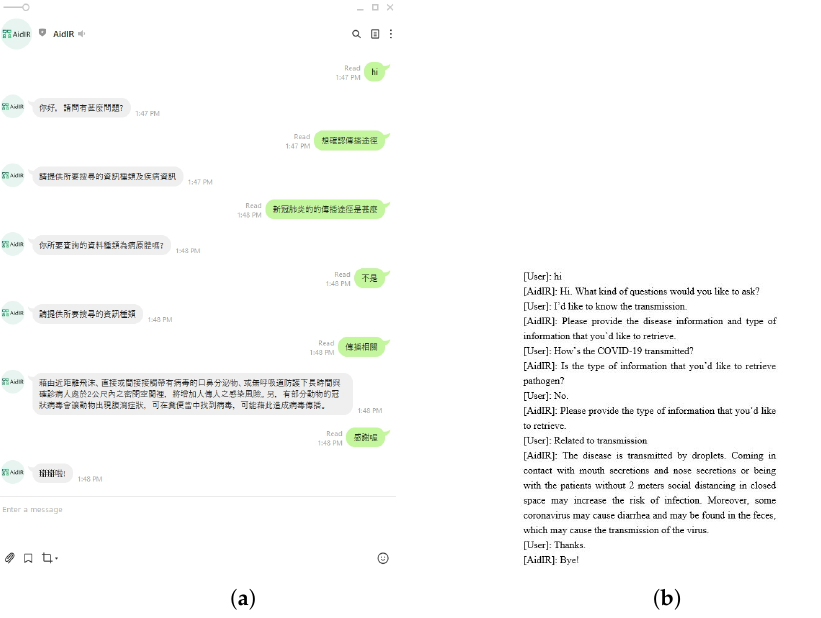
Figure 13. AidIR checks with the user but was rejected: ( a ) original dialog; and ( b ) dialog in English.